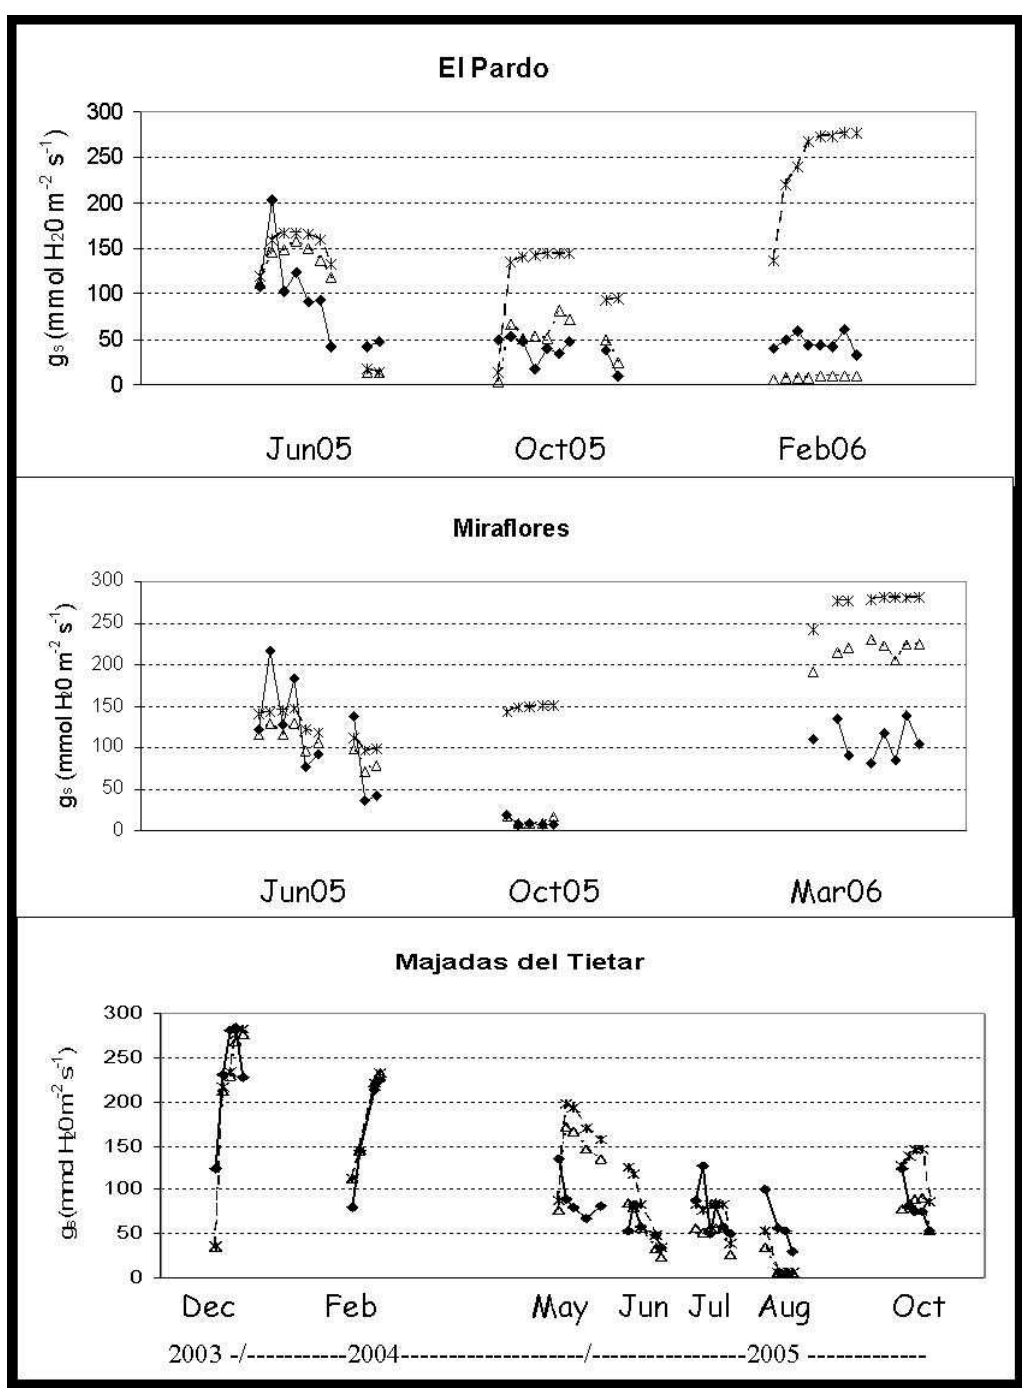
FIGURE 2. Validation of the g s model for Q. ilex using measured data at El Pardo and Miraflores during the period June 2005 through March 2006 and at Majadas del Tietar December 2003 through October 2005. ♦ , measured data; ∗ , calculated data based on literature review parameterization ; Δ , calculated data based on literature review parameterization including f SMD